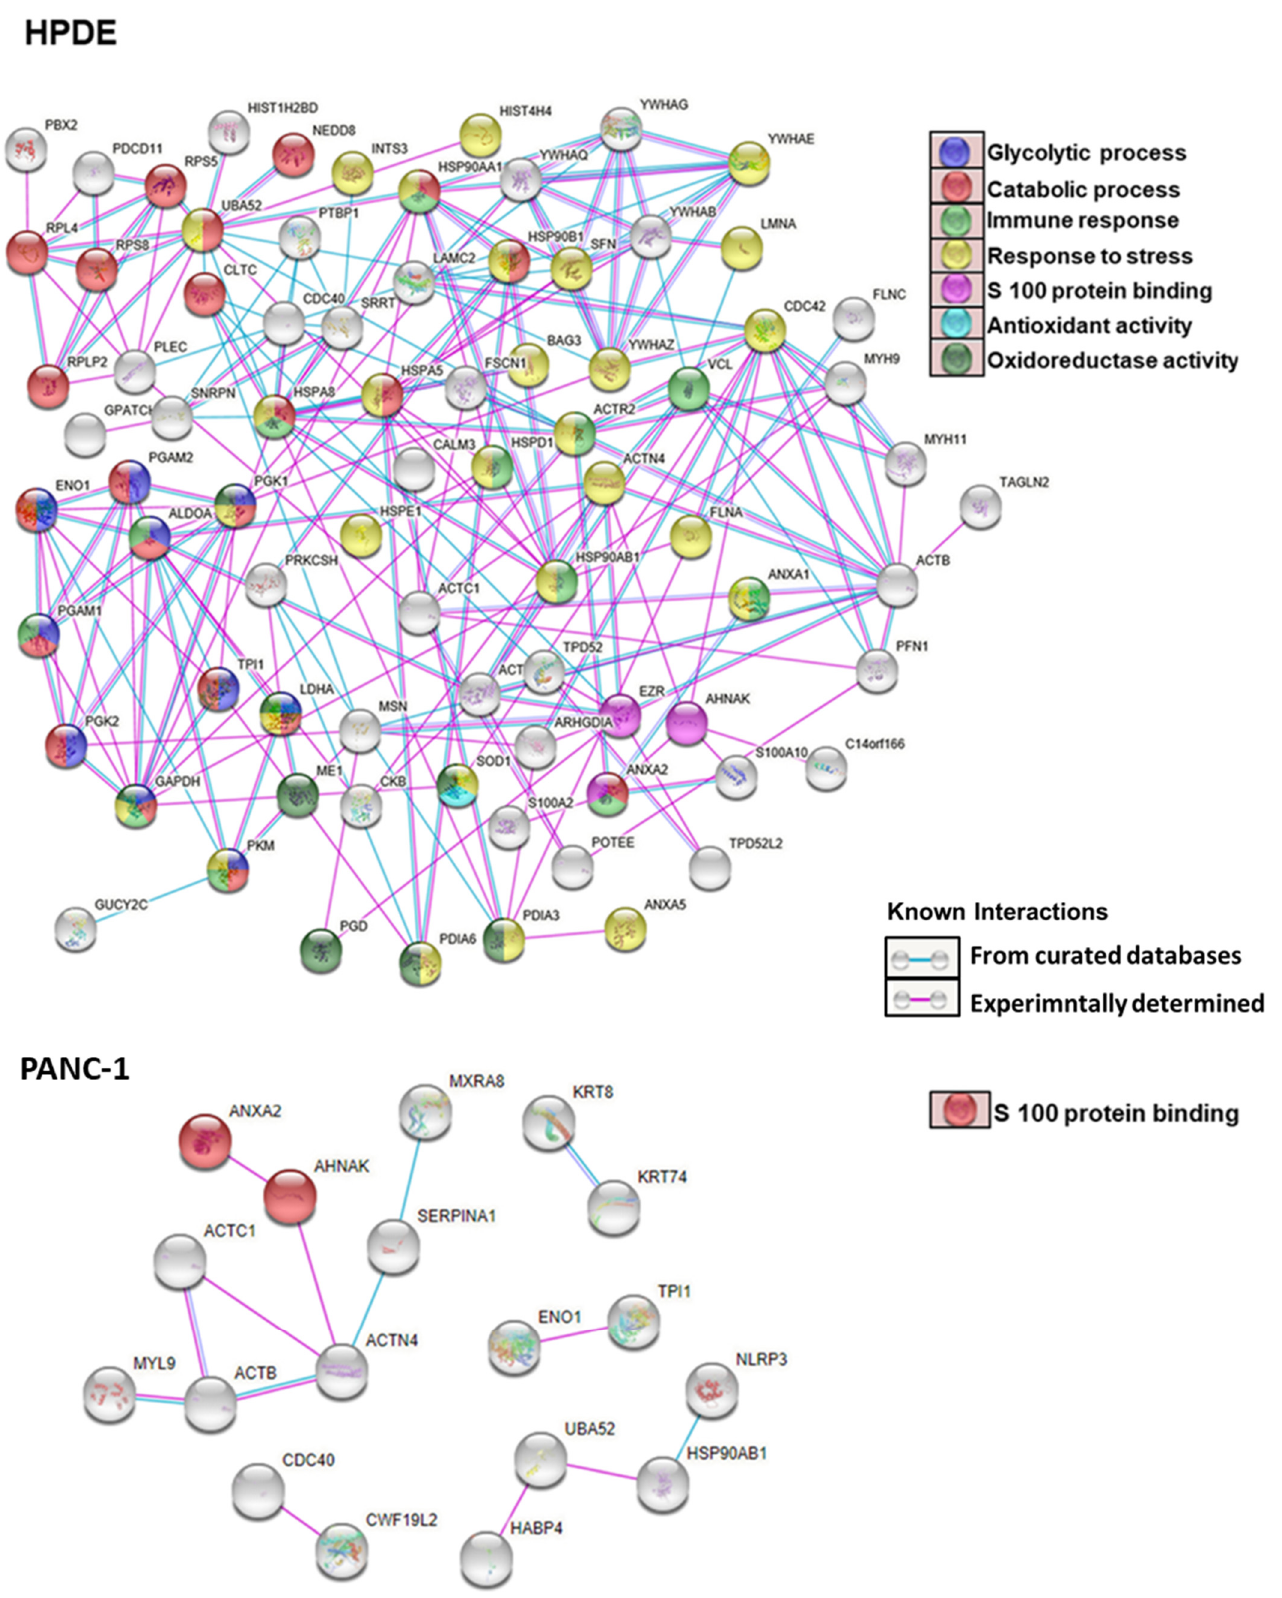
Figure 7. Protein–protein interactions (PPI) of proteins with glyceraldehyde-derived K/R modifications.